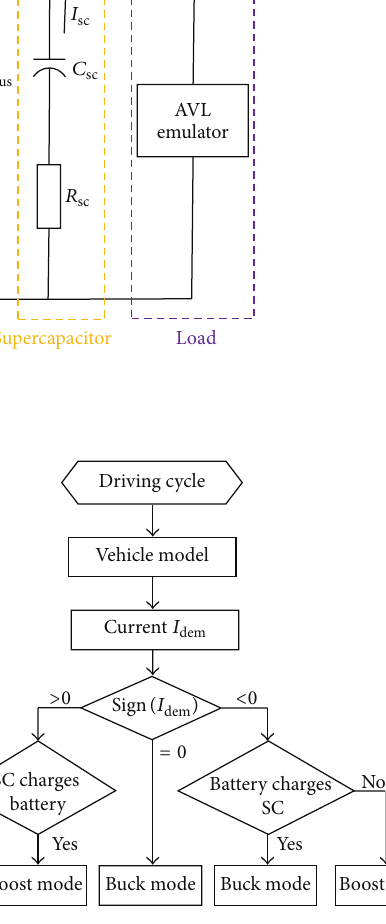
Figure 7: Flowchart of the DC/DC converter control mode